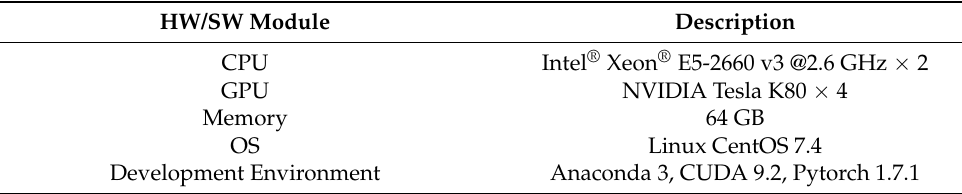
Table 1. System parameters of computing nodes.